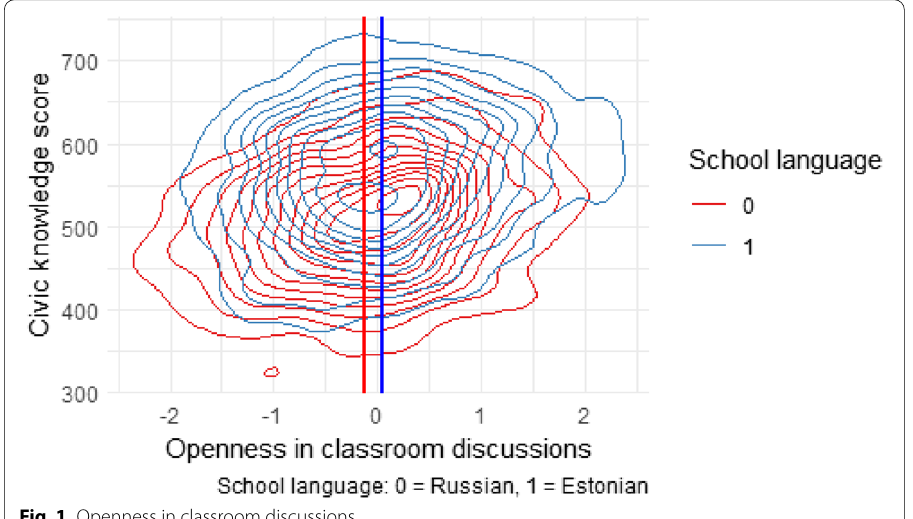
Fig. 1 Openness in classroom